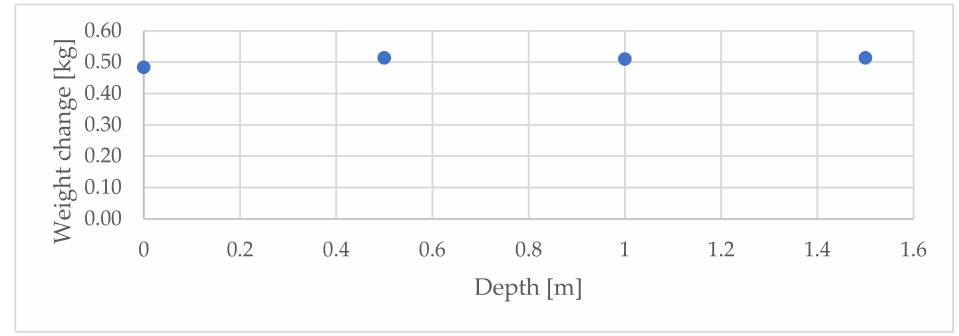
Figure 17. Buoyancy measurements at different depths (0 to 1.5 m with a 0.5 m step).